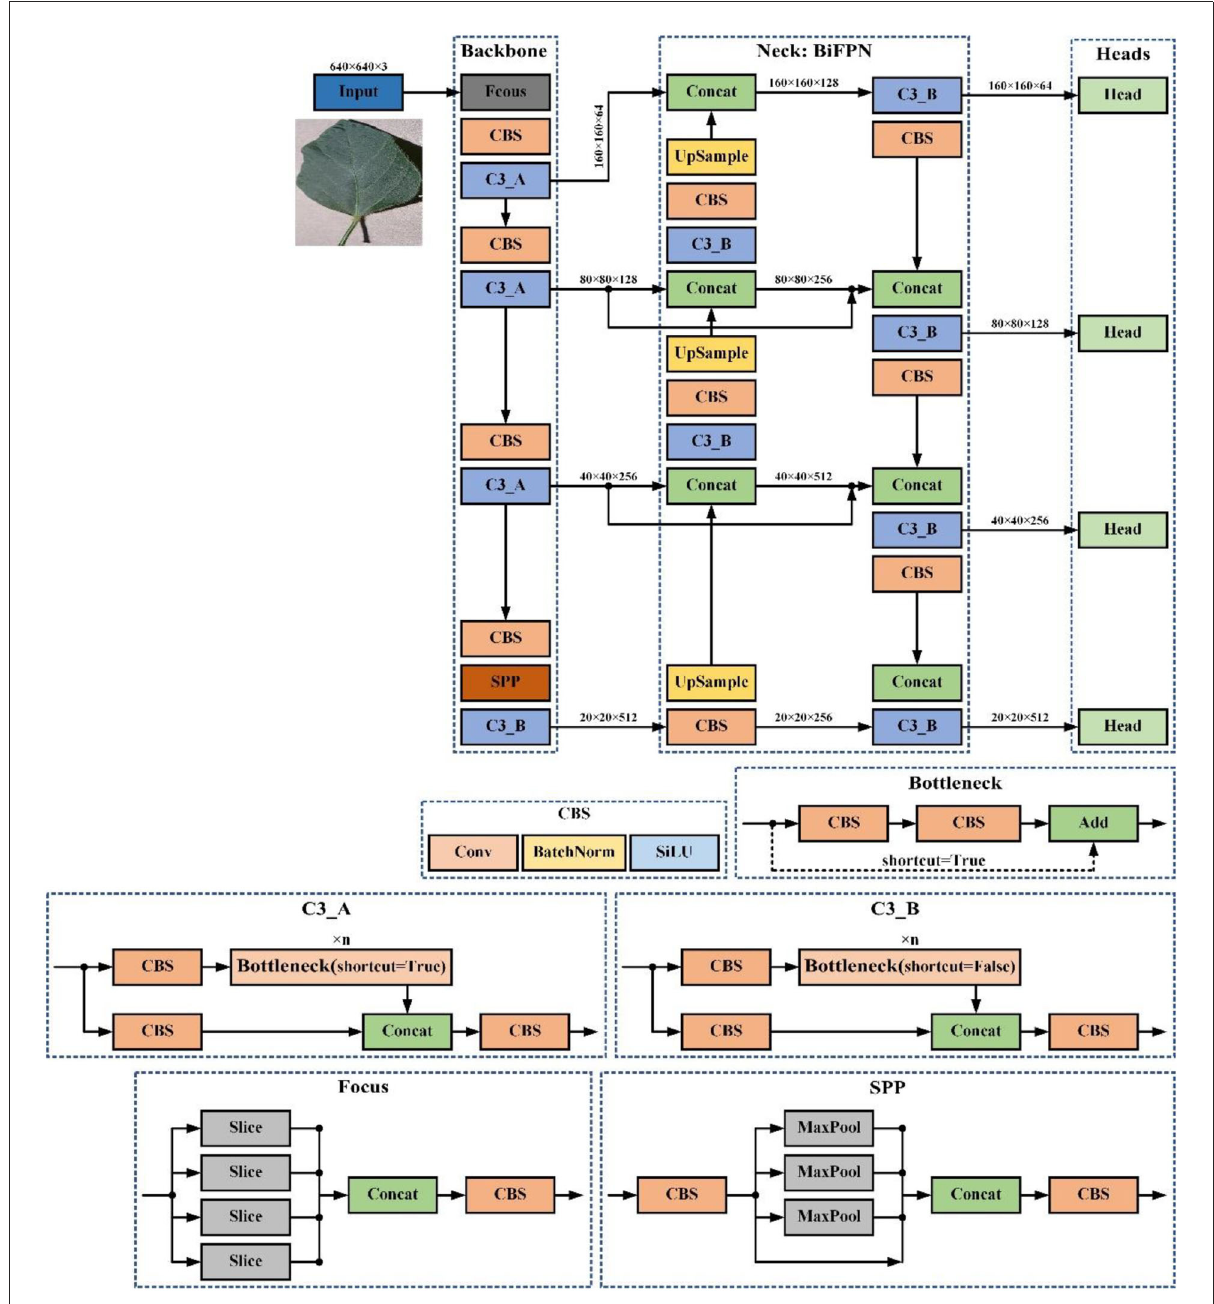
FIGURE4 YOLOv5-our structure